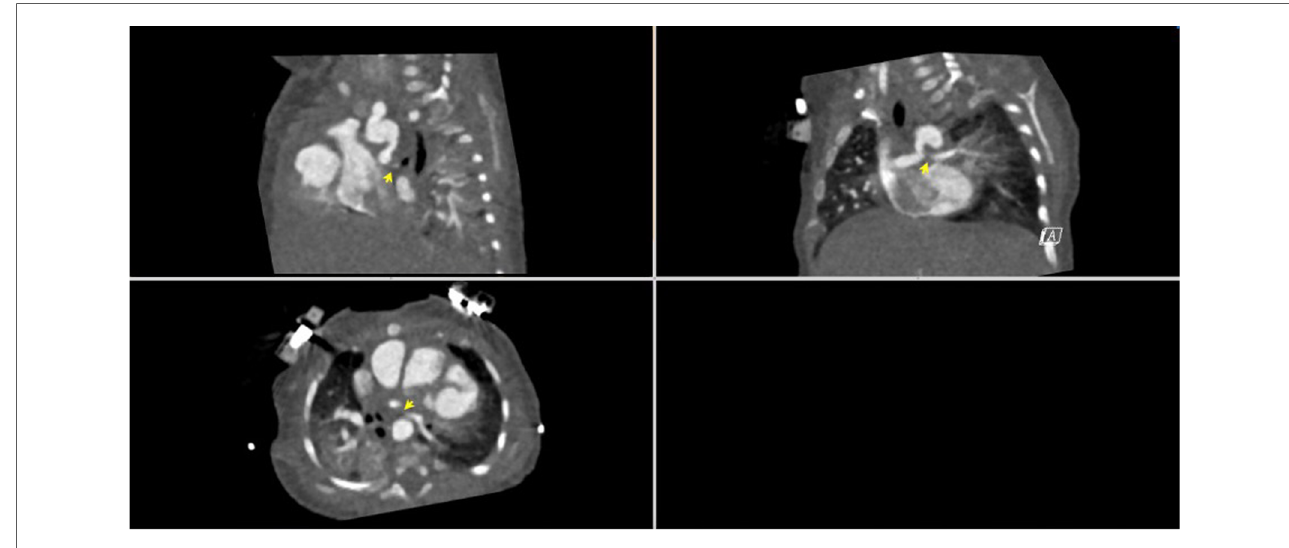
FIGURE 1 CT angiogram demonstrating the aorta-to-pulmonary central shunt that originates from the under-side of the distal transverse artic arch immediately underneath the origin of the left subclavian artery. The proximal LPA is not visualized. The LPA reconstitutes distally and is diffusely hypoplastic.